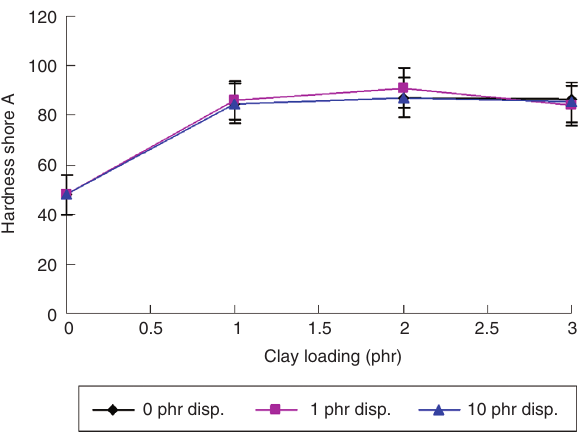
Figure 6 Hardness as a function of clay loading.